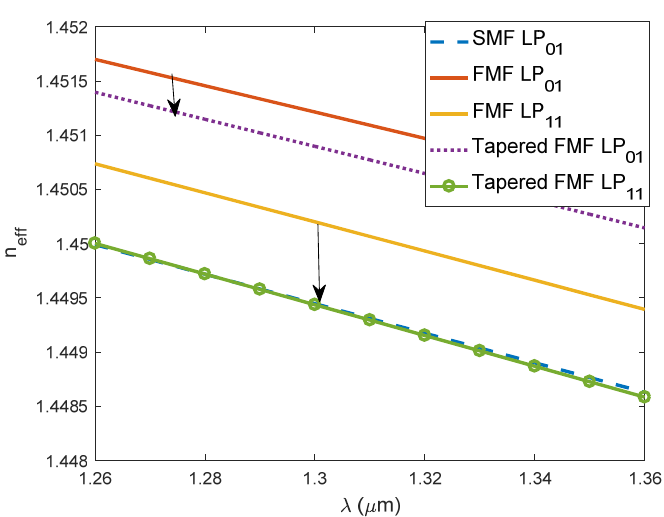
Figure 2. Phase matching curves of the modes in FMF and SMF.